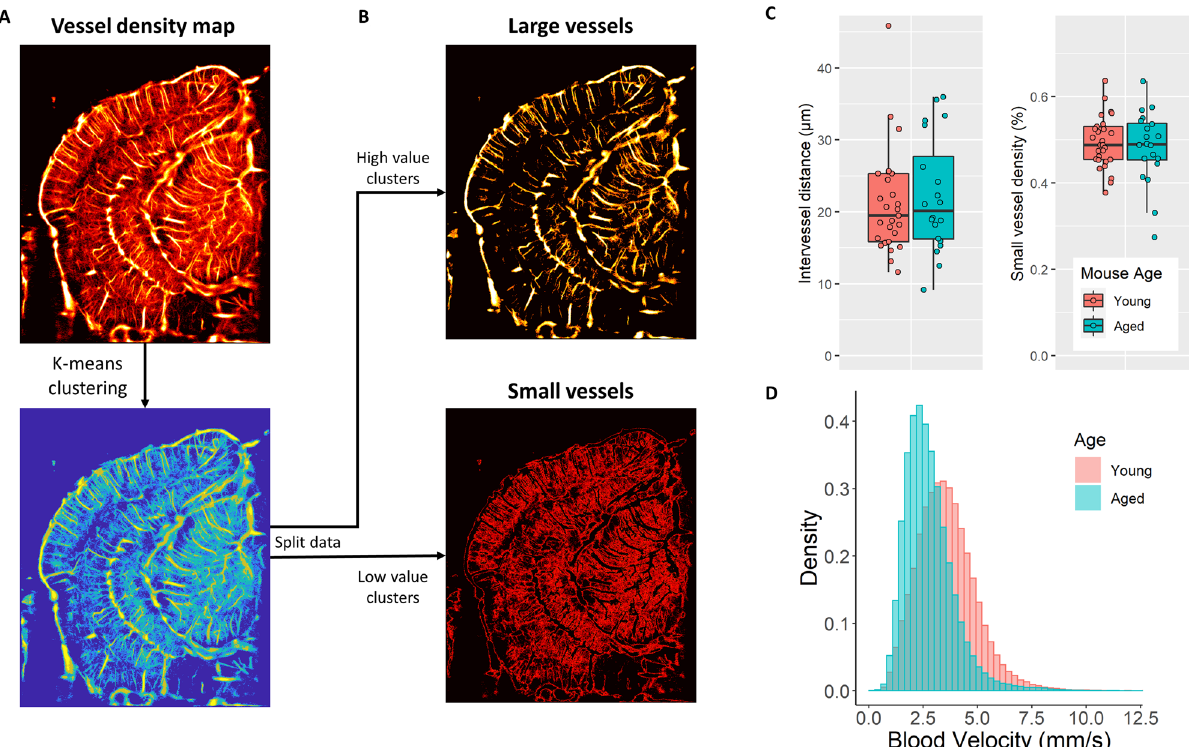
Figure 4. ULM image clustering and distributional analysis. ( A ) Super-resolution vessel maps were clustered based on microbubble accumulation density using K-means clustering with 6 clusters. ( B ) Splitting the clustered map into separate high-valued and low-valued images allowed for the generation of large vessel and small vessel representations of the ULM data, respectively. ( C ) The mean intervessel distance across the entire coronel hemisphere for the large vessel map could be calculated, along with the microvascular density for the small vessel map, for all mice in each age group. No significant difference was found between the age groups for either of these metrics. ( D ) Representative histograms of the blood velocities across the entire coronel hemisphere from an example young and aged mouse, demonstrating a shift in the distribution shape. Across all mice in this study, we found a significantly increased right skewness (1.16 vs. 0.98, p = 0.002) in the distribution of blood velocities of the whole brain in the aged cohort versus the young cohort. ULM images were rendered